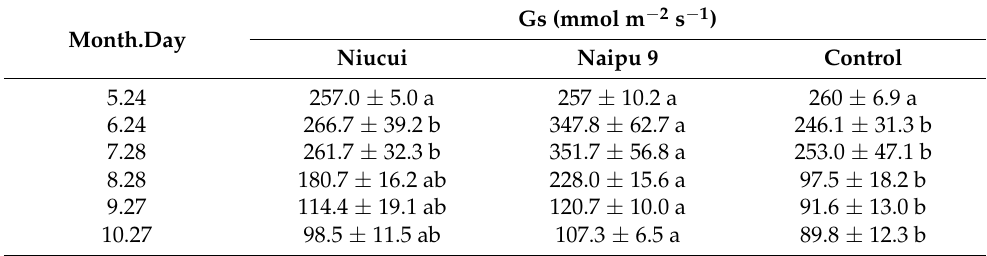
Table 7. Effects of spraying calcium fertilizer on stomatal conductance (Gs) of apple leaves. Month.Day